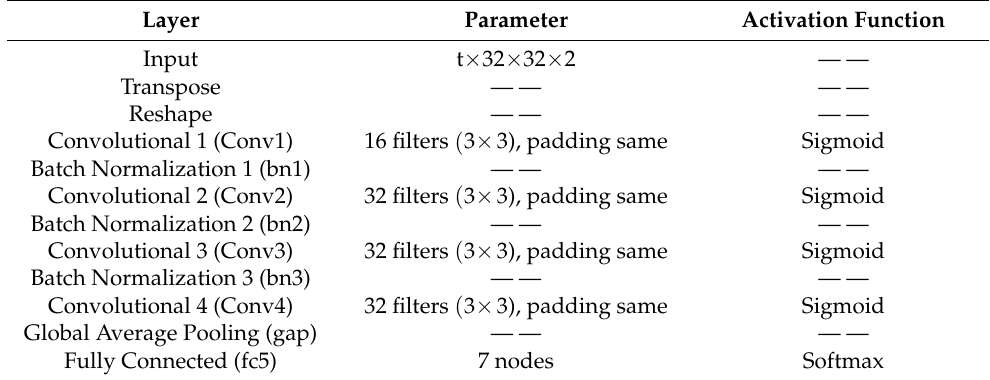
Table 6. Parameters of the sea ice classification network based on CNN. Layer Parameter Activation Function Input t × 32 × 32 × 2 — — Transpose — — — — Reshape — — — — Convolutional 1 (Conv1) 16 filters ( 3 × 3), padding same Sigmoid Batch Normalization 1 (bn1) — — — — Convolutional 2 (Conv2) 32 filters ( 3 × 3), padding same Sigmoid Batch Normalization 2 (bn2) — — — — Convolutional 3 (Conv3) 32 filters ( 3 × 3), padding same Sigmoid Batch Normalization 3 (bn3) — — — — Convolutional 4 (Conv4) 32 filters ( 3 × 3), padding same Sigmoid Global Average Pooling (gap) — — — — Fully Connected (fc5) 7 nodes